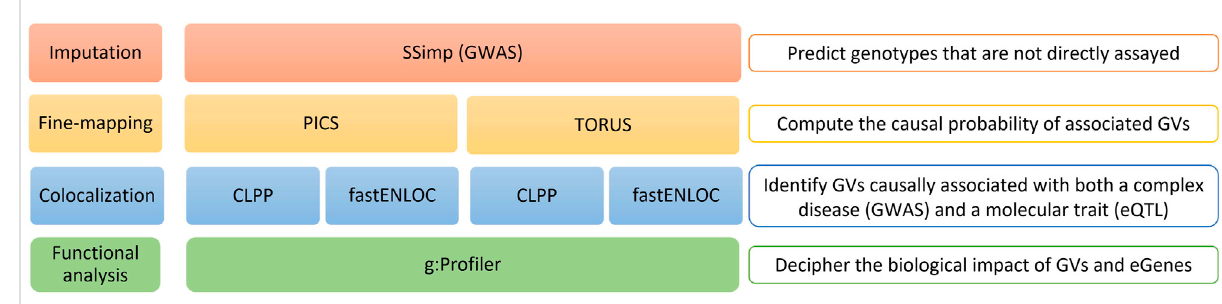
FIGURE 1 Overview of the study work fl ow. Schematic representation of the entire analysis work fl ow: 1) SSimp Imputation; 2) Alternative fi ne-mapping with PICS and TORUS; 3) Alternative colocalization analysis with CLPP and fastENLOC to both PICS and TORUS fi ne-mapping results; and 4) Functional analysis of the GVs and eGenes obtained at the end of the work fl ow. SSimp, Summary Statistics Imputation software; GWAS, genome- wide association studies; PICS, Probabilistic Identi fi cation of Causal SNPs; CLPP, Colocalization Posterior Probability; fastENLOC, Fast Enrichment Estimation Aided Colocalization Analysis; GVs, genetic variants; eGenes, genes regulated by expression quantitative trait